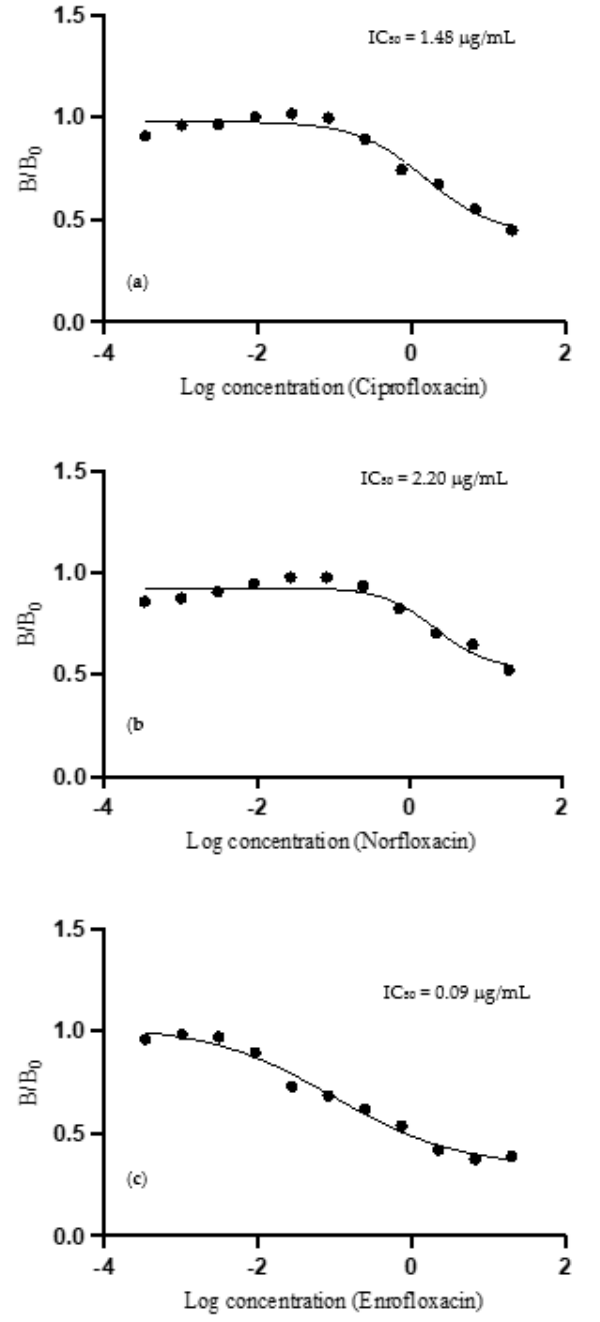
Figure 5. The inhibition curve of fluoroquinolone antibiotics by using the CPFX – BSA activation of the antibody and CPFX – OVA as the coating antigen; ( a ) ciprofloxacin; ( b ) norfloxacin; ( c ) enroflox-